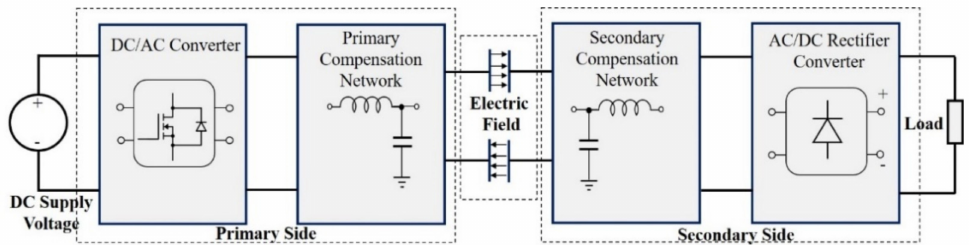
Figure 1. Block diagram of a general capacitive wireless power transfer